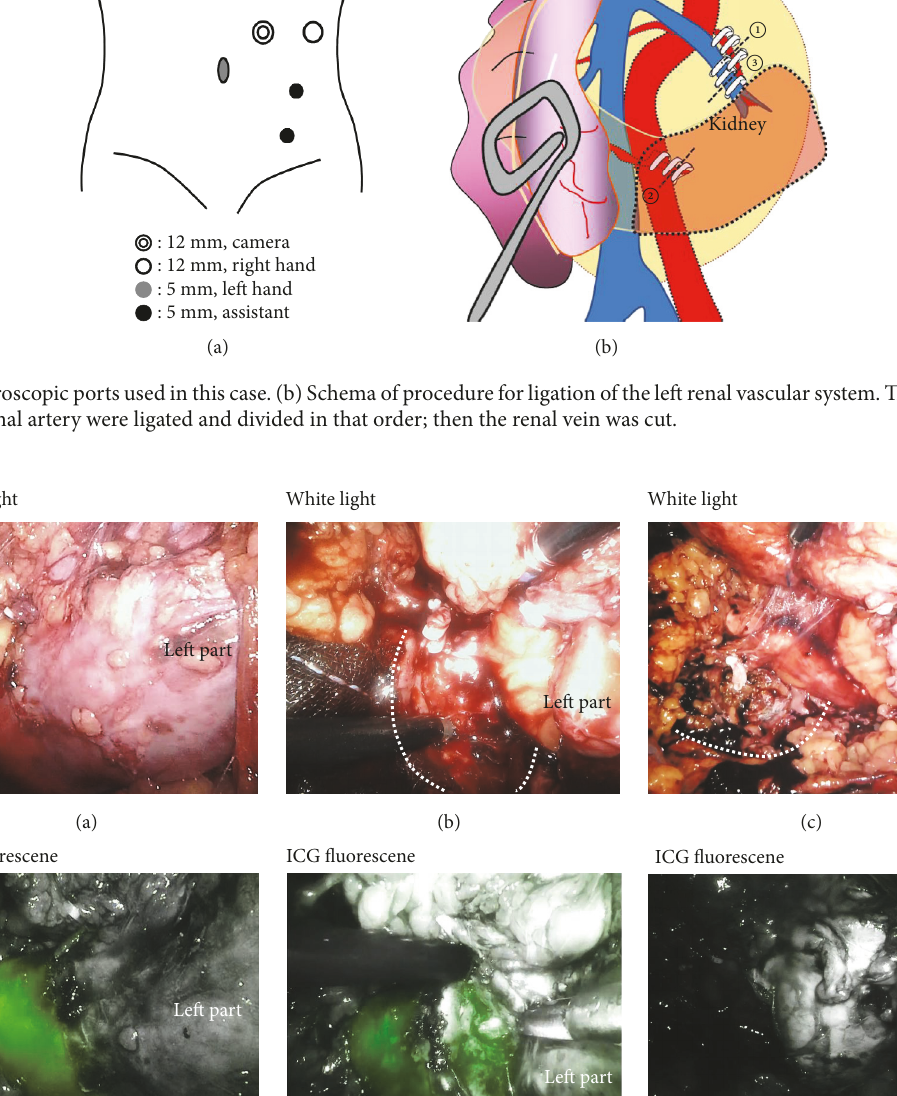
Figure 3: (a) Gross appearance of horseshoe kidney under white light after blockage of blood supply to the left kidney. (b) Resection of the renal isthmus under white light. Dotted circle indicates renal isthmus border. (c) Resected surface of right part of kidney under white light. Adequate hemostasis was obtained by bipolar coagulation and a fibrin patch. Dotted circle indicates renal isthmus border. (d) ICG-based NIRF images showing strong ICG fluorescence in the dominant region of the right part of the kidney after blockage of blood supply to the left kidney. (e) Proper resection of the renal isthmus could be performed with assistance from NIRF imaging. (f) Adequate hemostasis of the resected surface of the right part of the kidney was confirmed using ICG-based NIRF